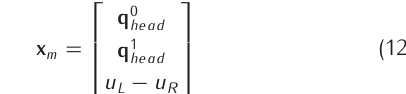
robot end-e(cid:636)ector is represented by a visual marker (a green ball in this case) that can be attached either to the wrist (as a marker for the hand) or to the tip of a 35 cm long flexible rubber tube (i.e. the tool); Figure 4 shows the two possible positions of the green ball on the robot. The position of the ball center in the cameras images is computed through visual processing (i.e. color based segmentation) with a precision of